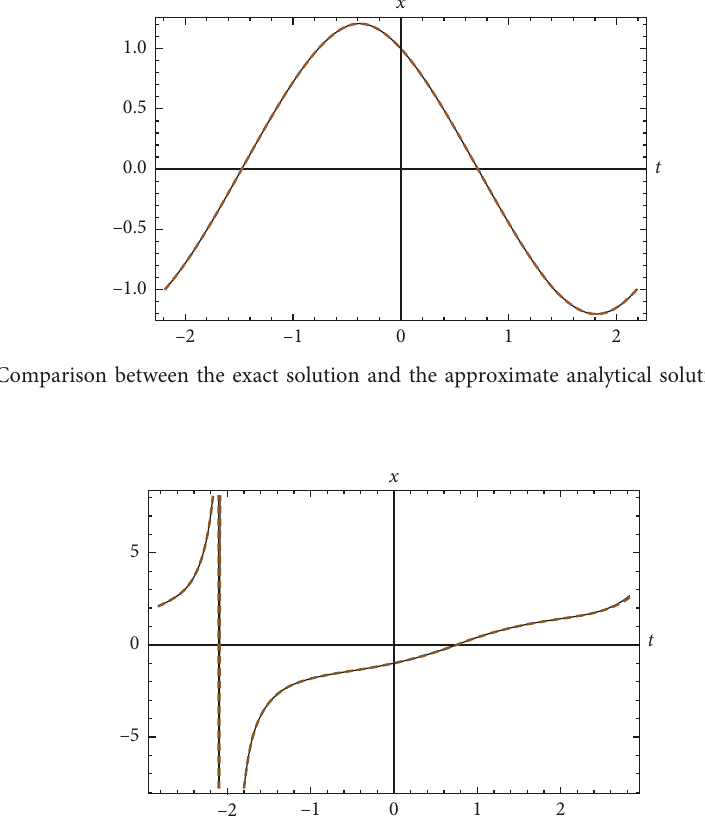
Figure 4: Comparison between the exact solution and the approximate analytical solution for Example 4.